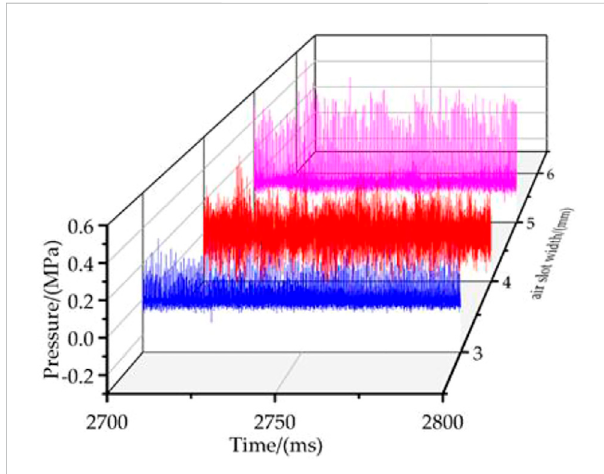
FIGURE 8 Comparison of pressure with different slot widths.